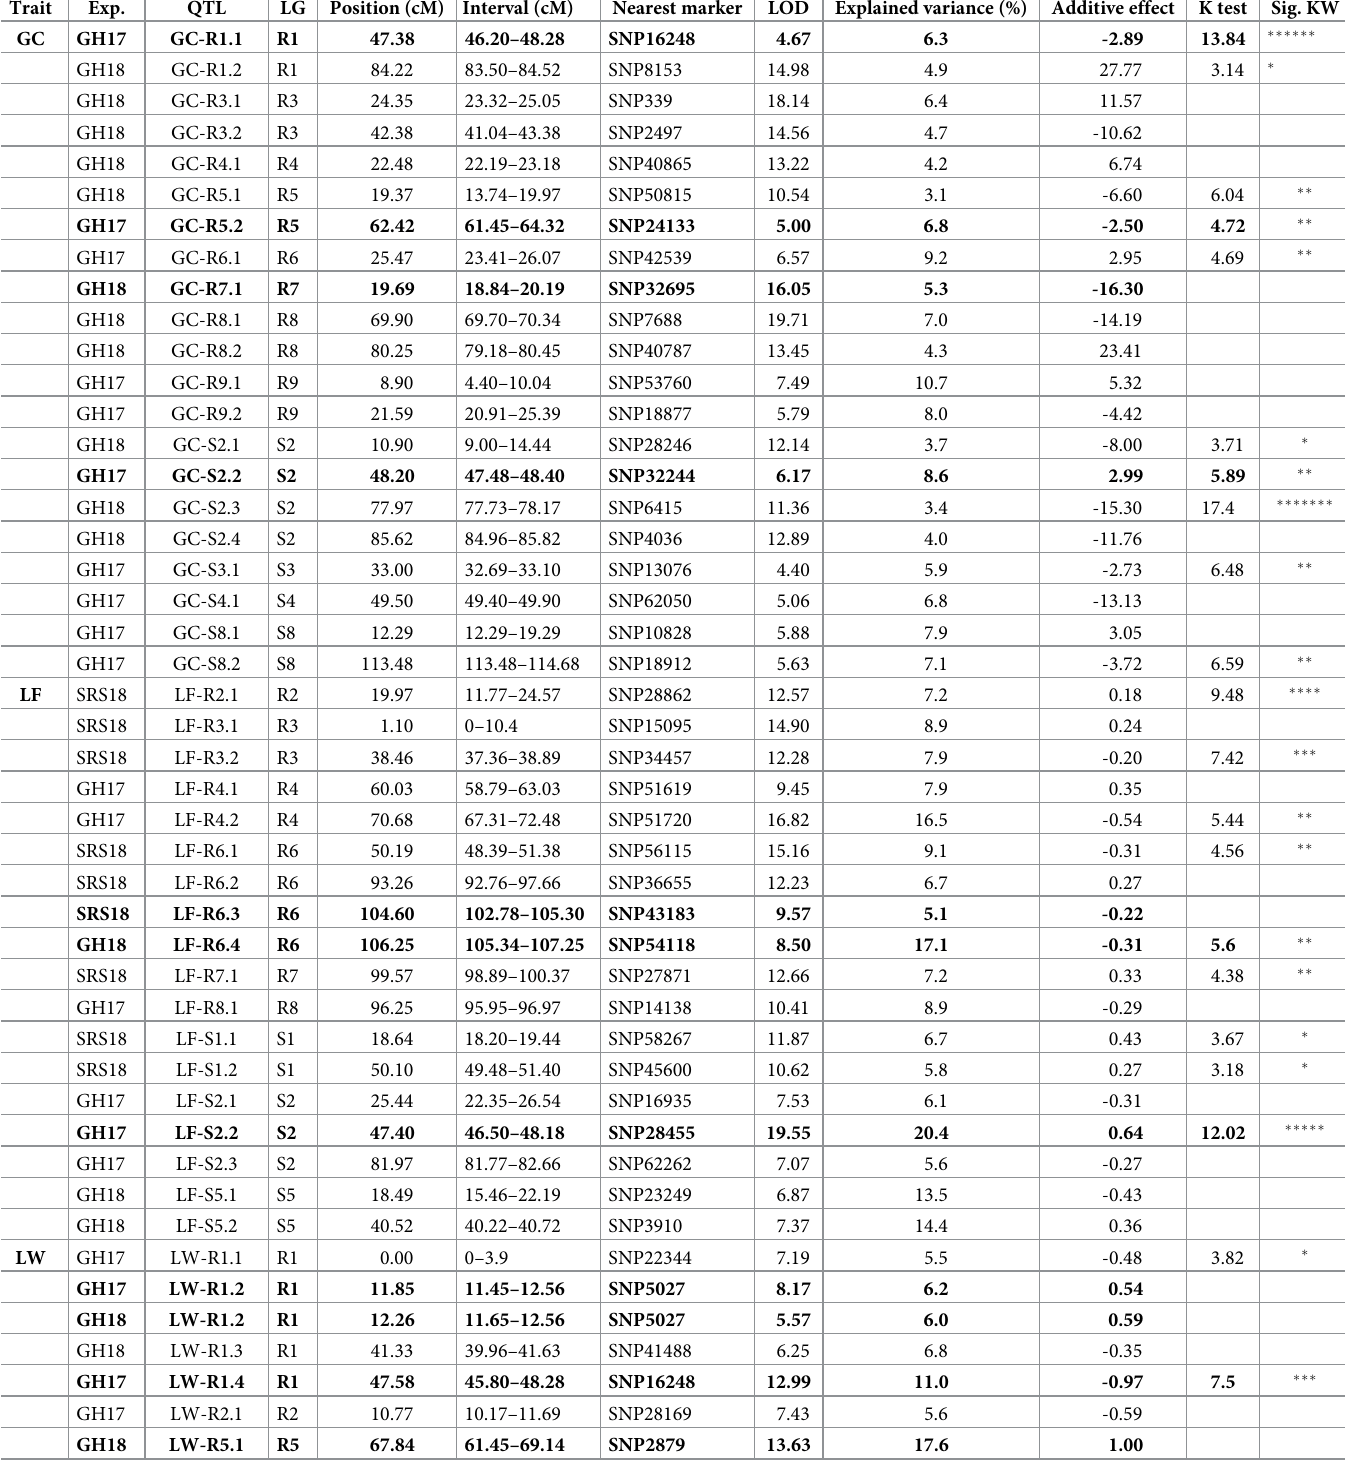
Table 3. Quantitative trait loci (QTL) found to have association with drought related traits in a St. Augustinegrass Raleigh x Seville F 1 population evaluated under greenhouse (GH17 and GH18) and field conditions (SRS18).